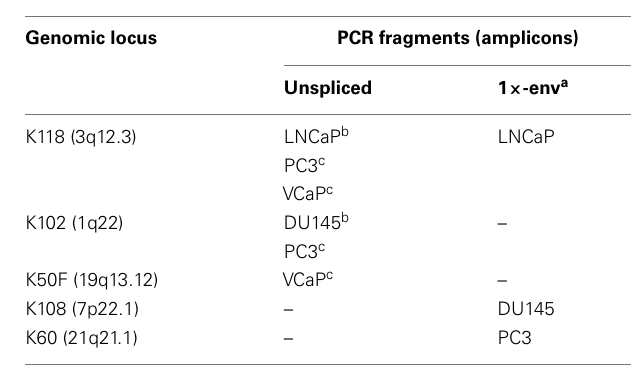
Table 3 | Cell lines where transcripts from specific HERV-K proviruses were